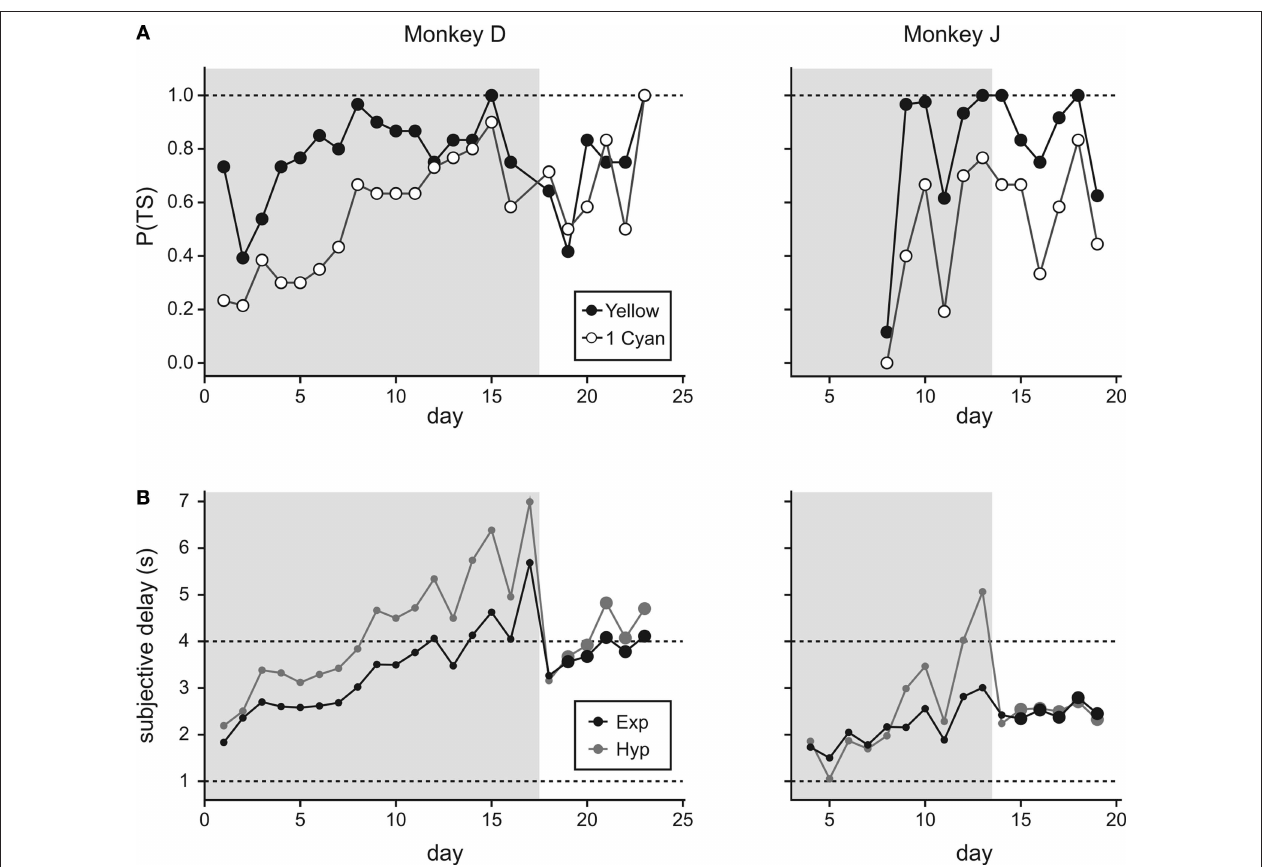
FIGURE 6 | Time course for the learning of delay information from the mixed clocks. (A) The plot shows daily changes in the probability that the animal would choose the small-reward target with a 2-s delay instead of the large-reward target with a 5-s delay. The delay for the large reward was indicated by either fi ve yellow disks (fi lled circles) or by a combination of a yellow disk and a cyan disk (empty circles). (B) Daily changes in the subjective delay attributed to a single cyan disk. This was determined separately for